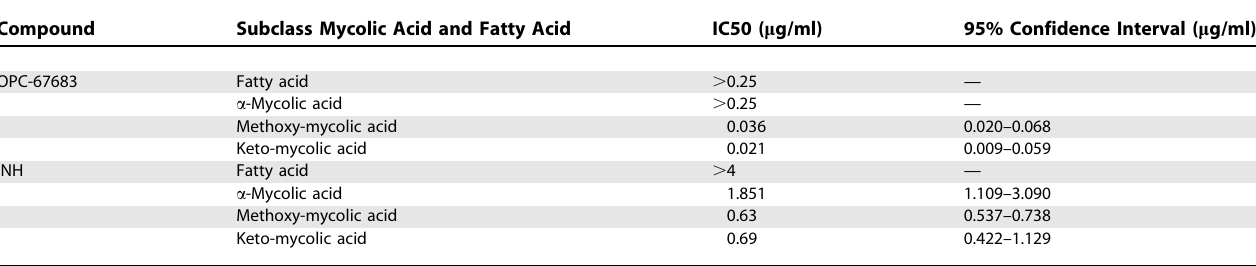
Table 5. IC 50 of OPC-67683 and INH against Mycolic Acid Synthesis